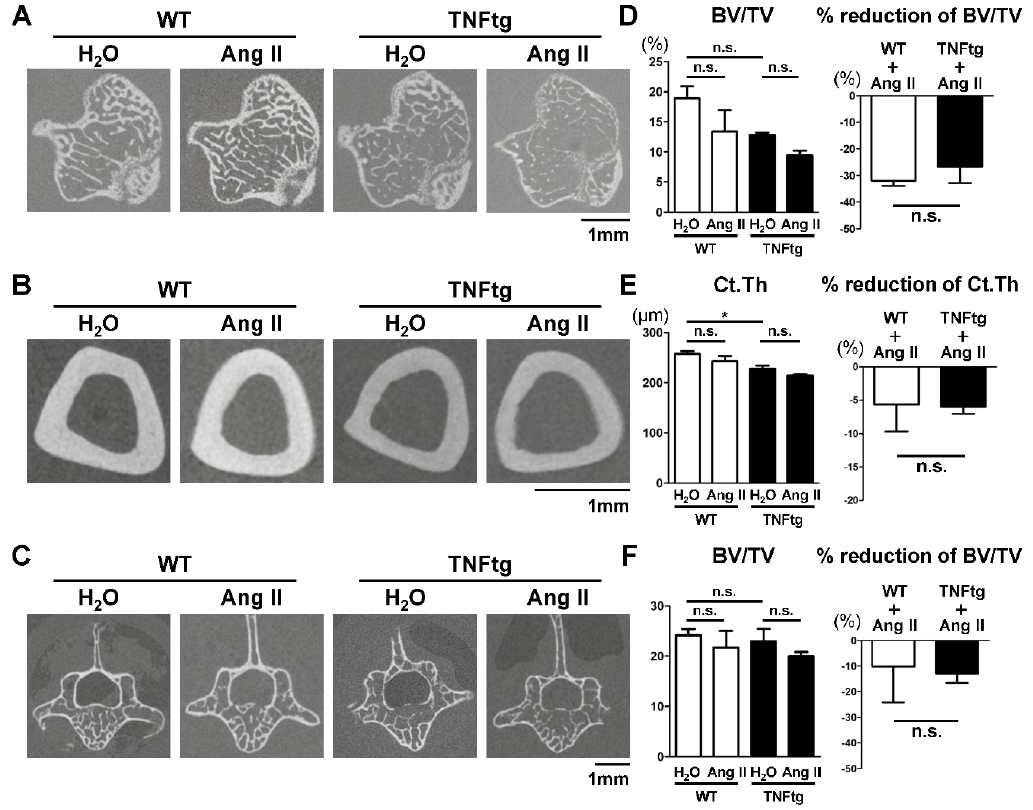
Figure 3. No detectable changes in the trabecular and cortical bone parameters with Ang II administration. Angiotensin II (Ang II) was administered by osmotic pumps to WT ( n = 6) and tumor